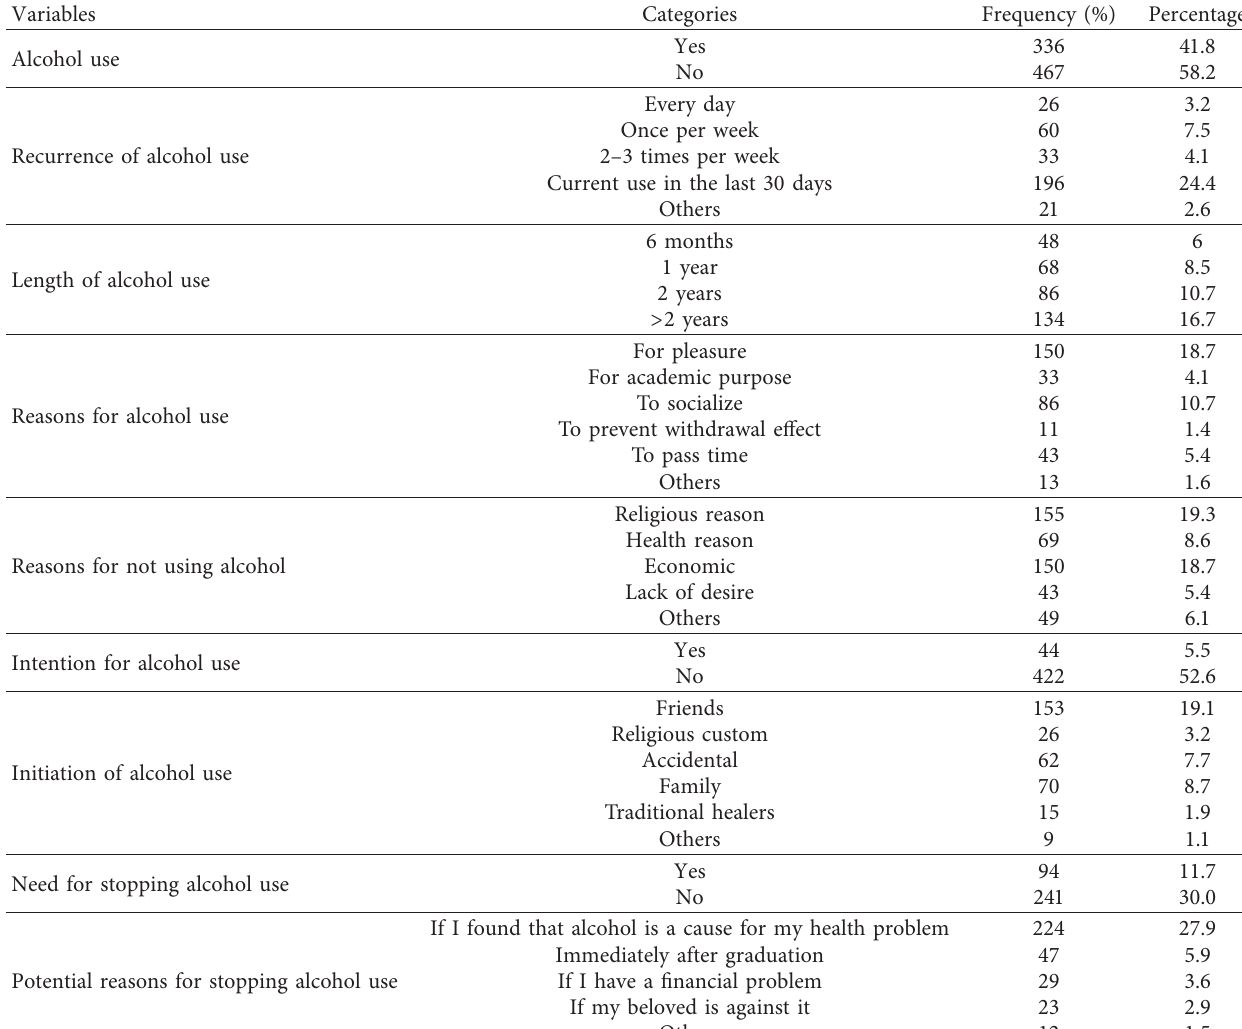
Table 2: Frequency and percentage of alcohol drinking of respondents in Dilla University, SNNPR, Ethiopia, 2018.